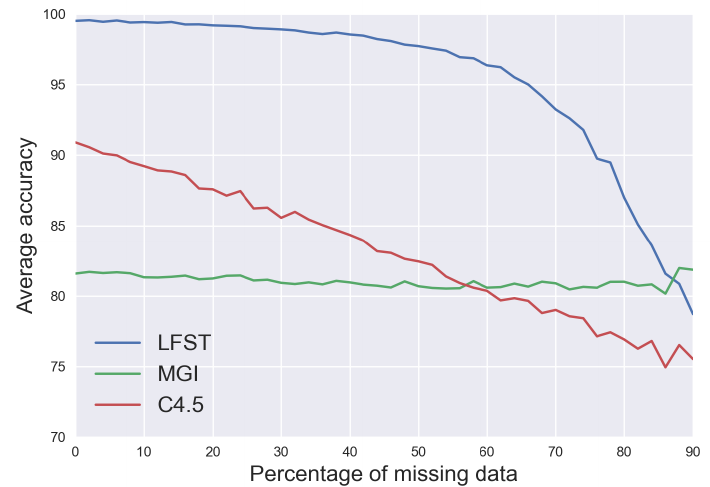
Figure 12. Comparison of the average accuracy in 421World.